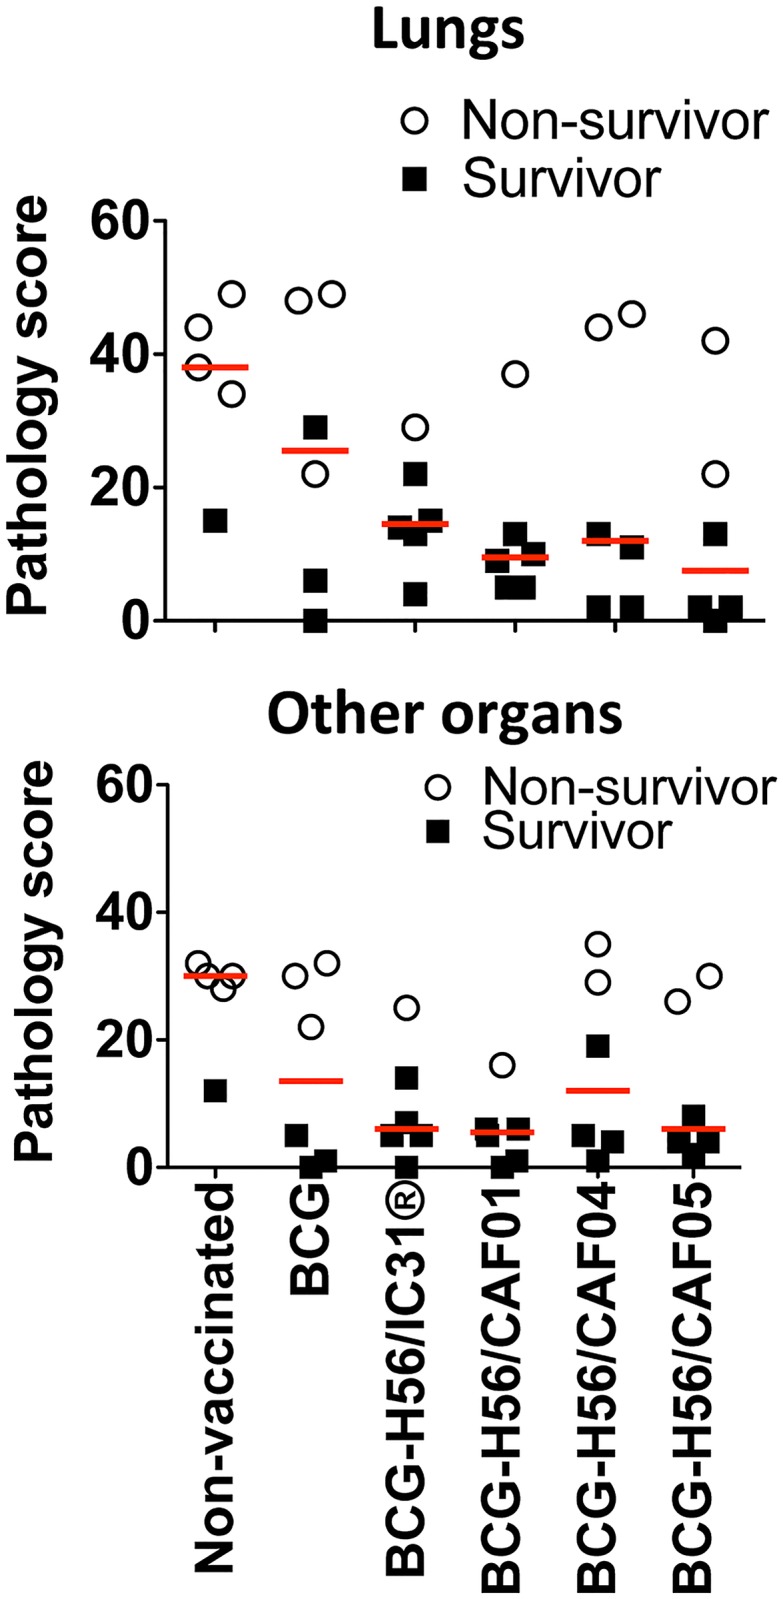
Lung and disseminated pathology in Mtb infected NHPs after boosting BCG with H56.Pathology scores in lungs and other organs (arbitrary units, for pathology scoring see MM) are shown for individual monkeys within different experimental vaccine groups. Median pathology scores are indicated with red horizontal lines for each group. Non-survivors, open circles, survivors, solid squares.